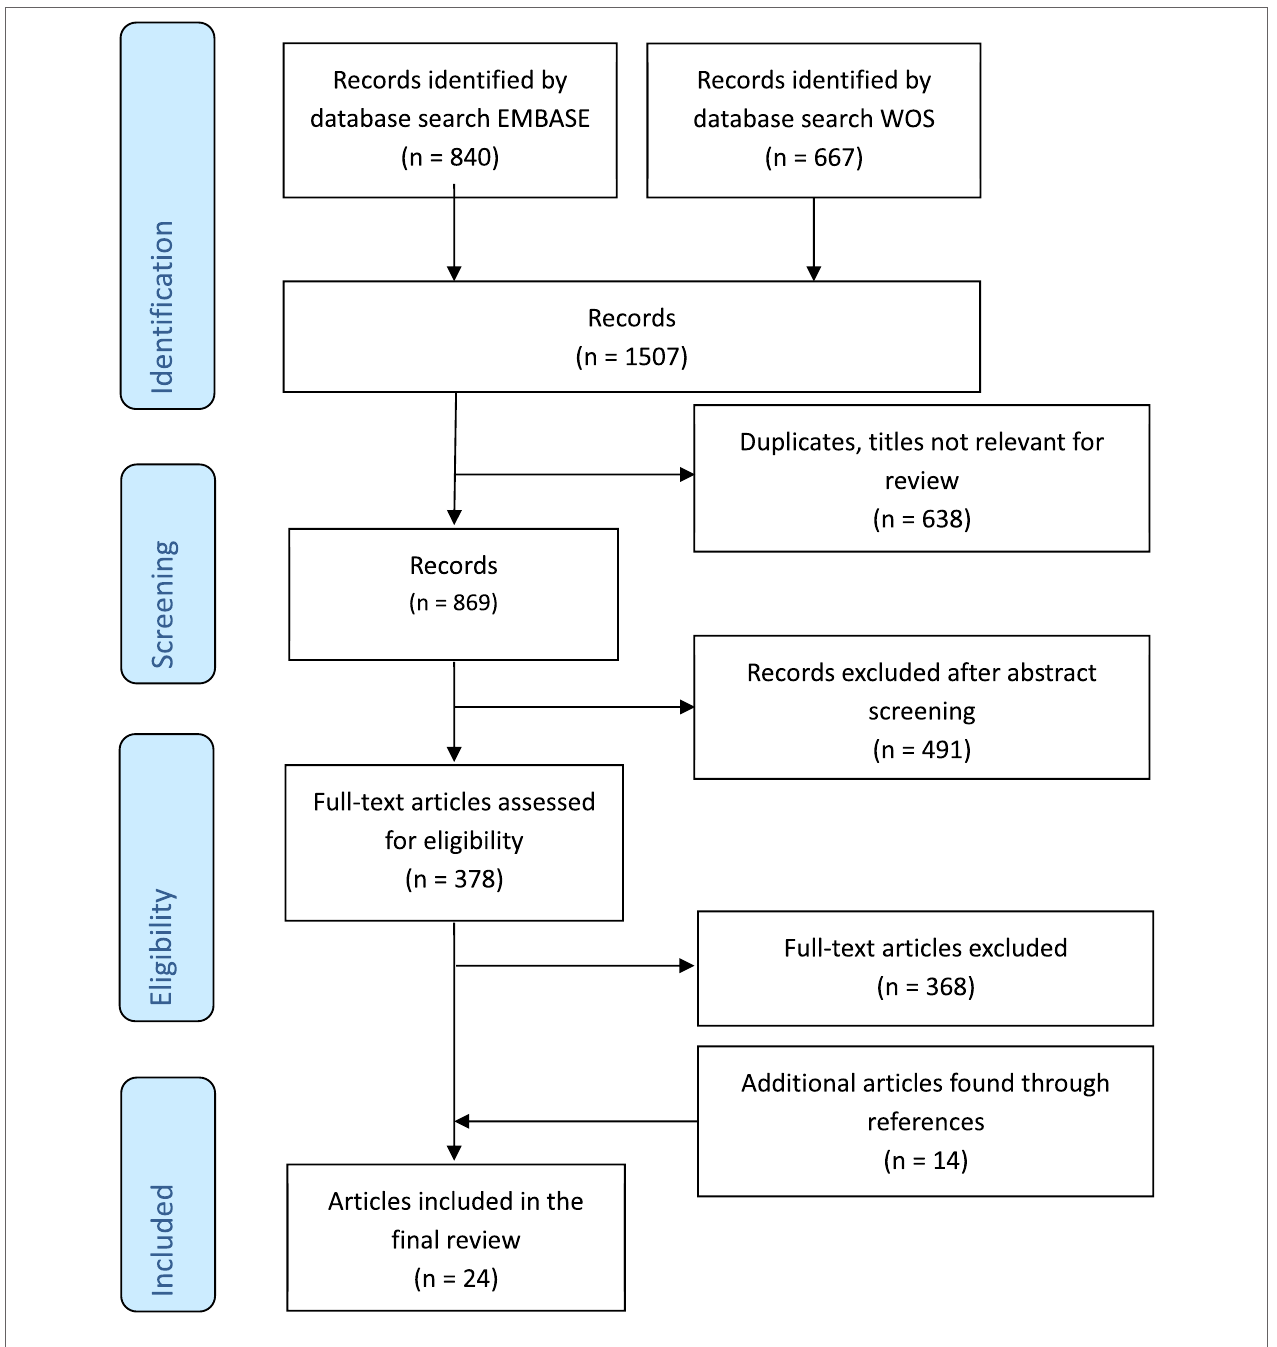
FiGURe 1 | Flow diagram of selected articles included in the